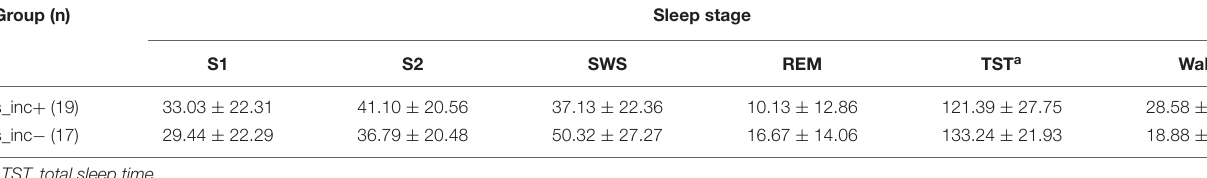
TABLE 3 | Minutes (M ± SD) spent in sleep stages.